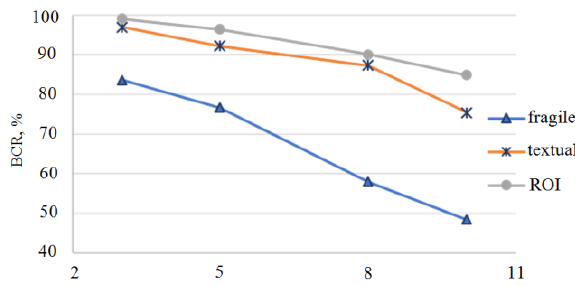
Figure 5. Watermark distortions under rotation attacks